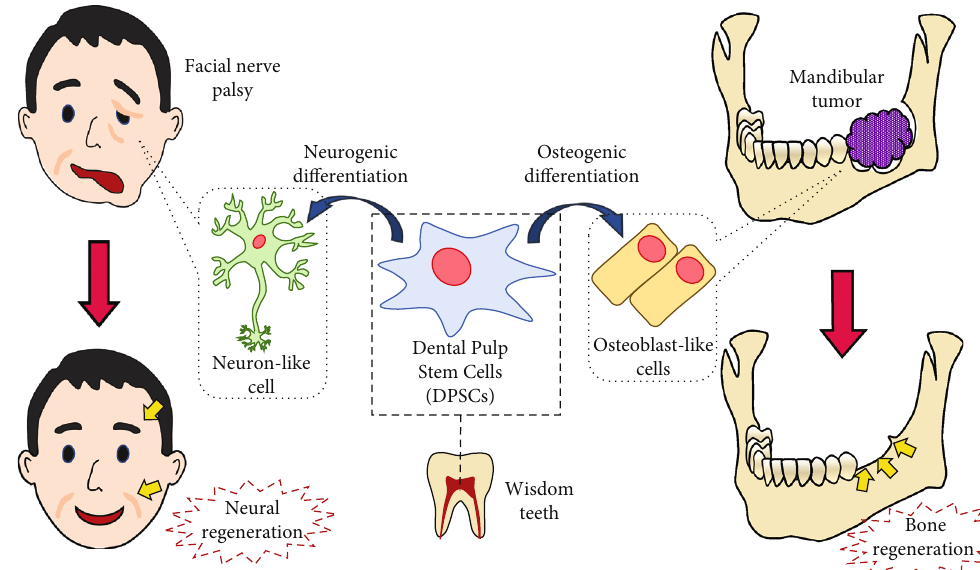
Figure 2: Graphical abstract. A therapeutic strategy for bone and neural regeneration with